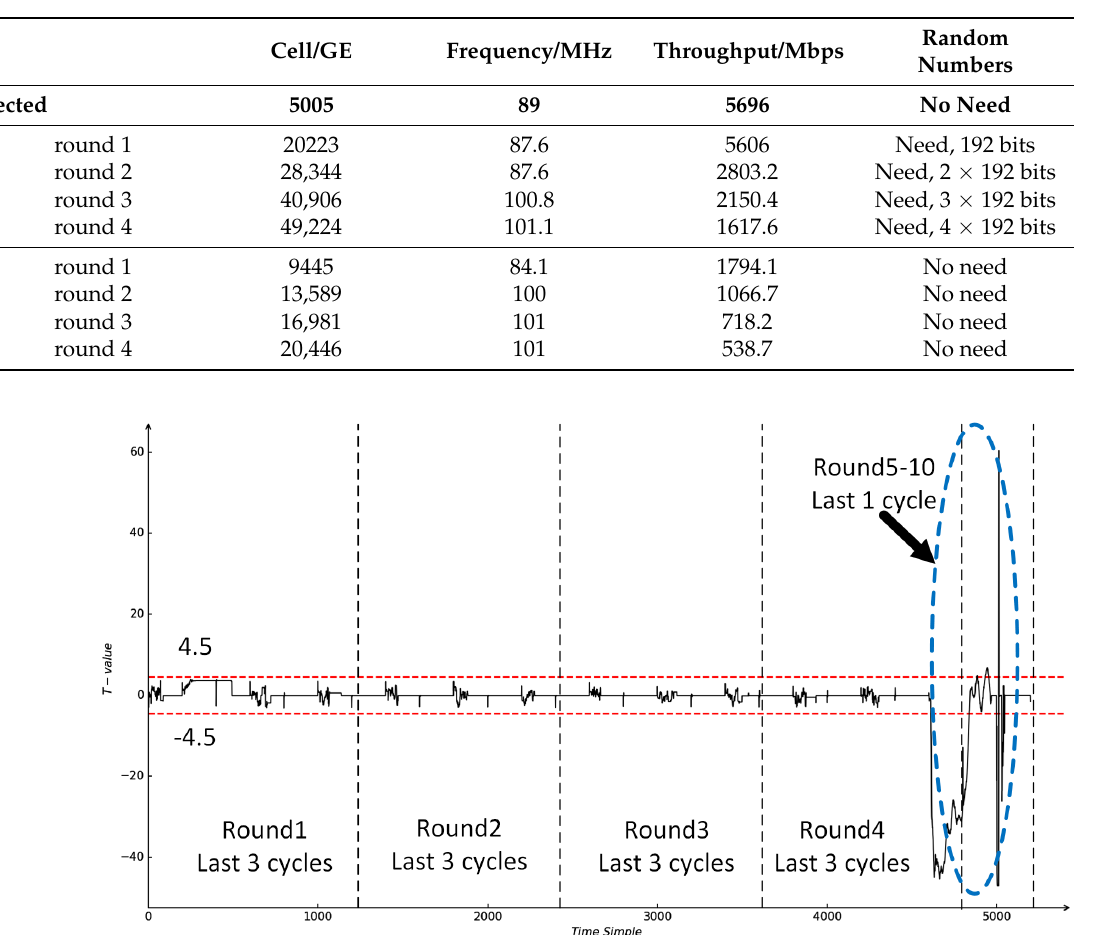
Figure 18. t -test for protection with scheme 2 for 4 rounds.